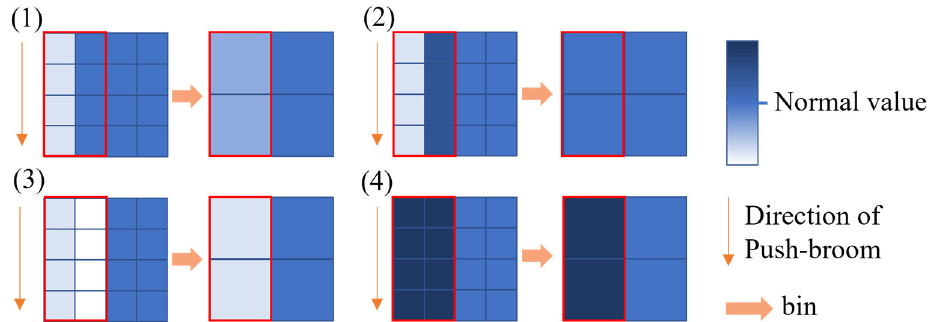
Figure 2. Four typical cases of MMS image element binning. All these phenomena indicate problems where blind elements cannot be removed directly by the calibration factors obtained before